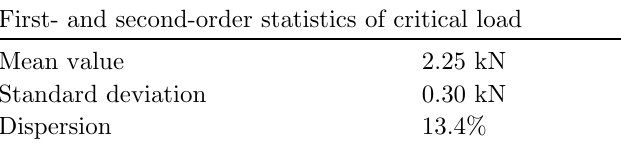
Fig. 3. Evolution of the measured load as a function of the imposed displacement of the screw head for each of the 20 compression tests. Table 3. First- and second-order statistical data on the critical load obtained from the 20 compression